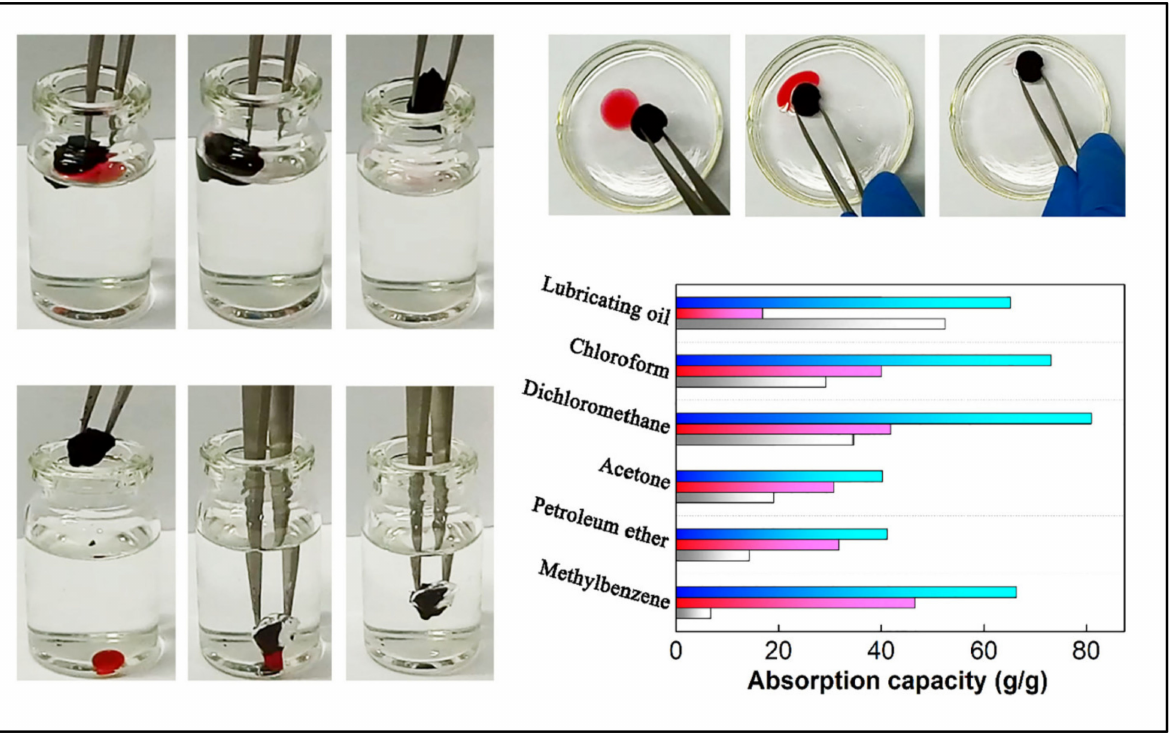
Figure 5. Nanocellulose/graphene aerogel in selective different oil absorption application, showing the high selectivity of the aerogel in oil absorption. Adapted from [90], with permission from Elsevier,